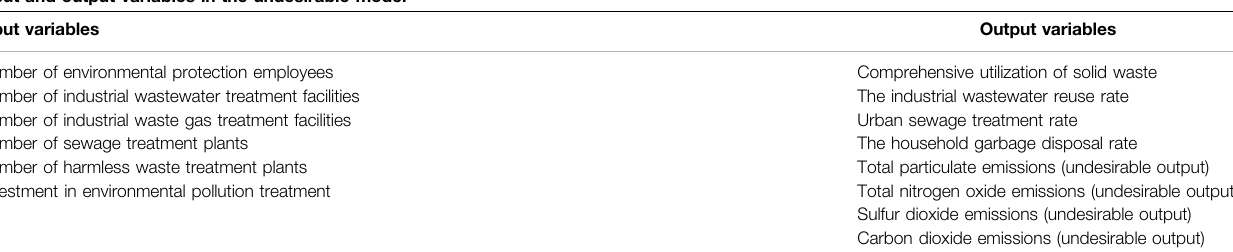
TABLE 1 | Input and output variables. Input and output variables in the undesirable model Input variables Output variables Number of environmental protection